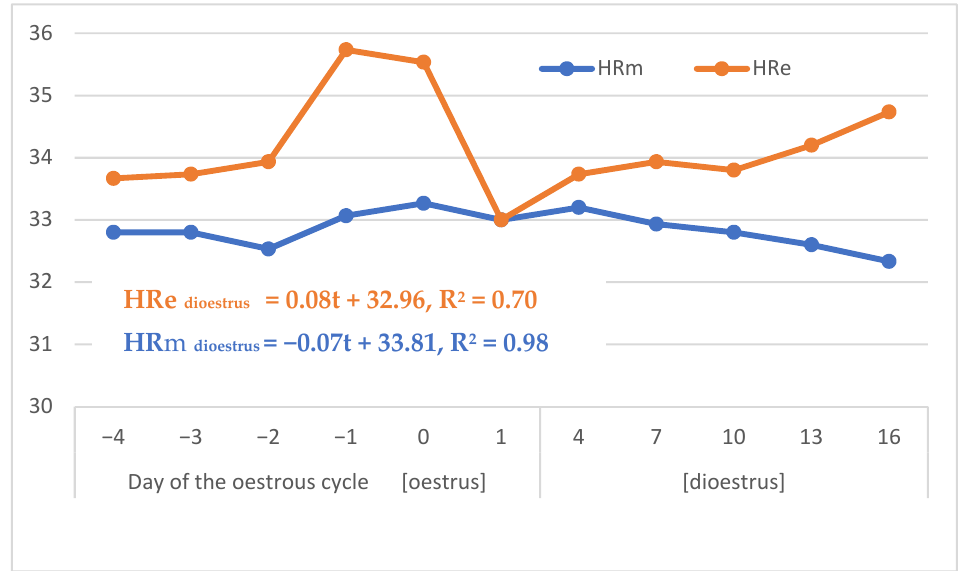
Figure 1. Dynamics of HR changes in the morning and evening during the oestrous cycle and regression models for dioestrus. HR—heart rate (beats per min).